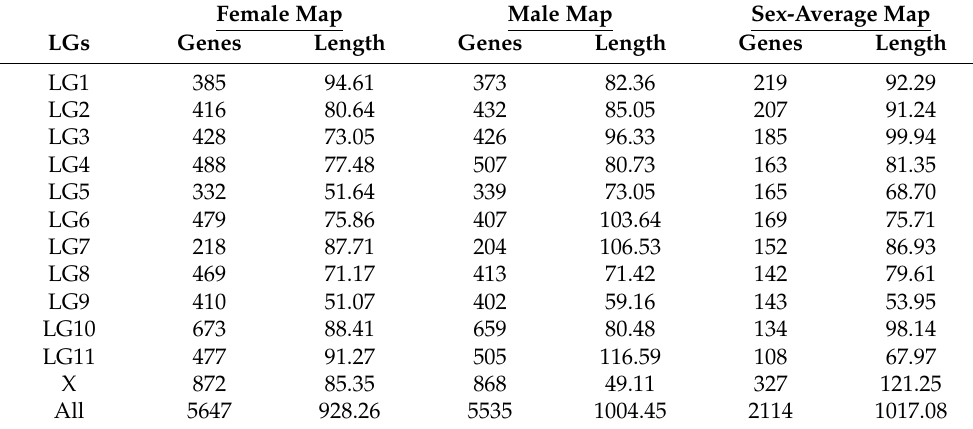
Table 1. The comparison of female, male and sex-average S. latifolia genetic maps. Female Map Male